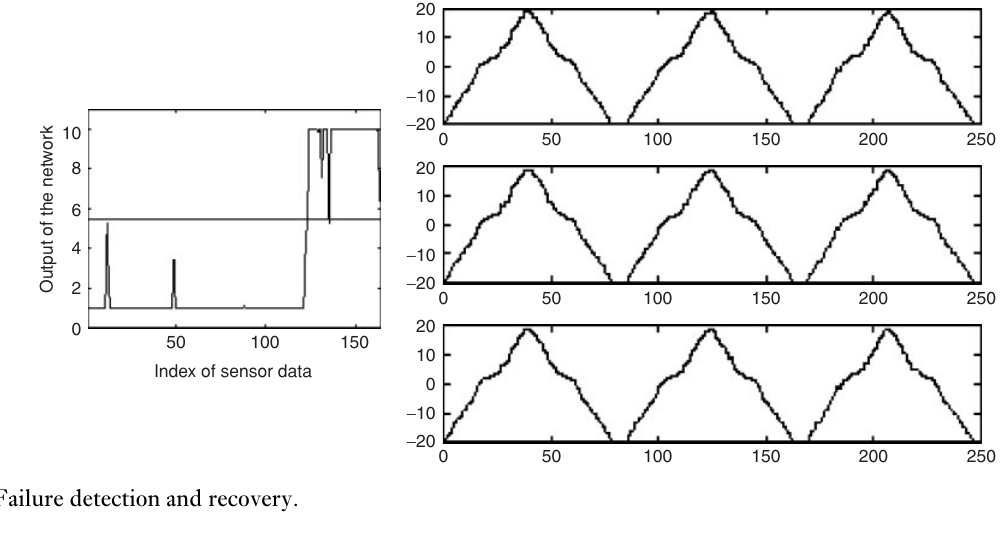
Table 1 The variance of the data from each set of configuration